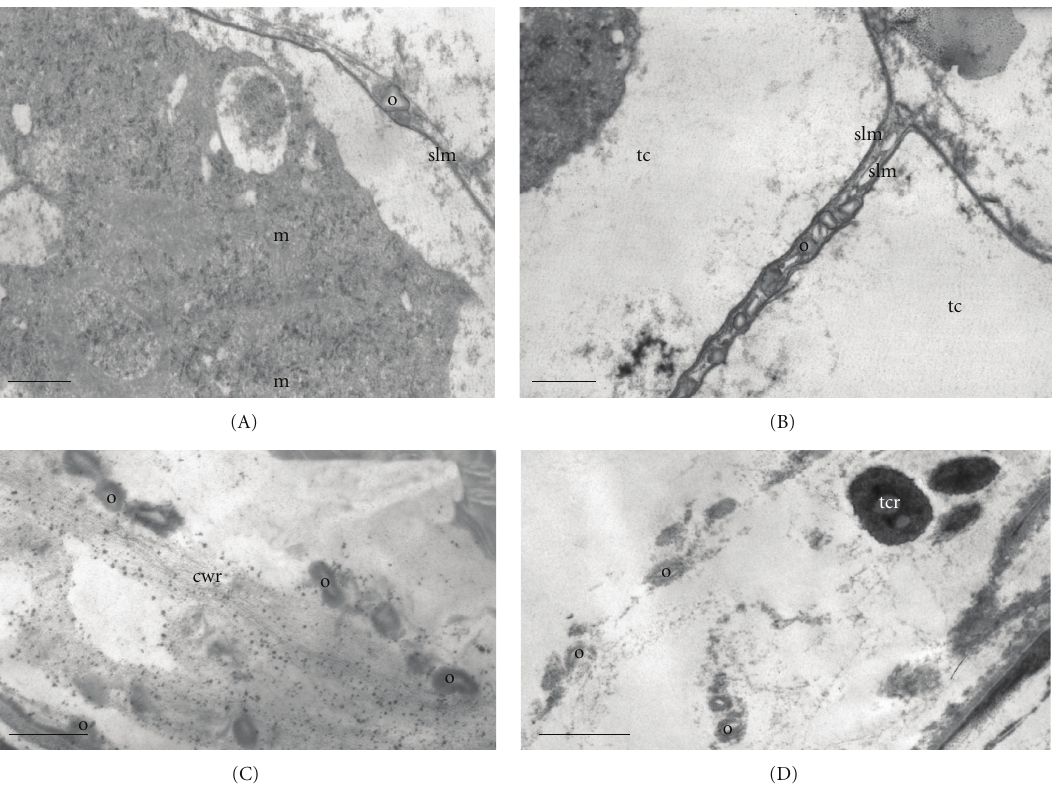
Figure 4: (A)-(B) Stage 4: young pollen grain. (C)-(D) Stage 5: mature pollen grain. (A)–(C) Colletia paradoxa. (D) Discaria americana. (A) Tapetal cell cytoplasm in degradation with some mitochondria (m) still recognizable and orbicules (o) attached to a sporopollenin- like. membrane (slm). (B) Orbicules (o) attached to the radial face of the sporopollenin-like membrane (slm) formed between two tapetal cells (tc) (C) Remains of the tapetal wall (cwr) with orbicules (o) and details of the sporopollenin-like membrane (slm) with orbicules (o) attached. (D) Orbicules (o) and tapetal cell remains (tcr). Scale bar: (A)-(B) 850nm; (C) 500nm; (D) 1 µ